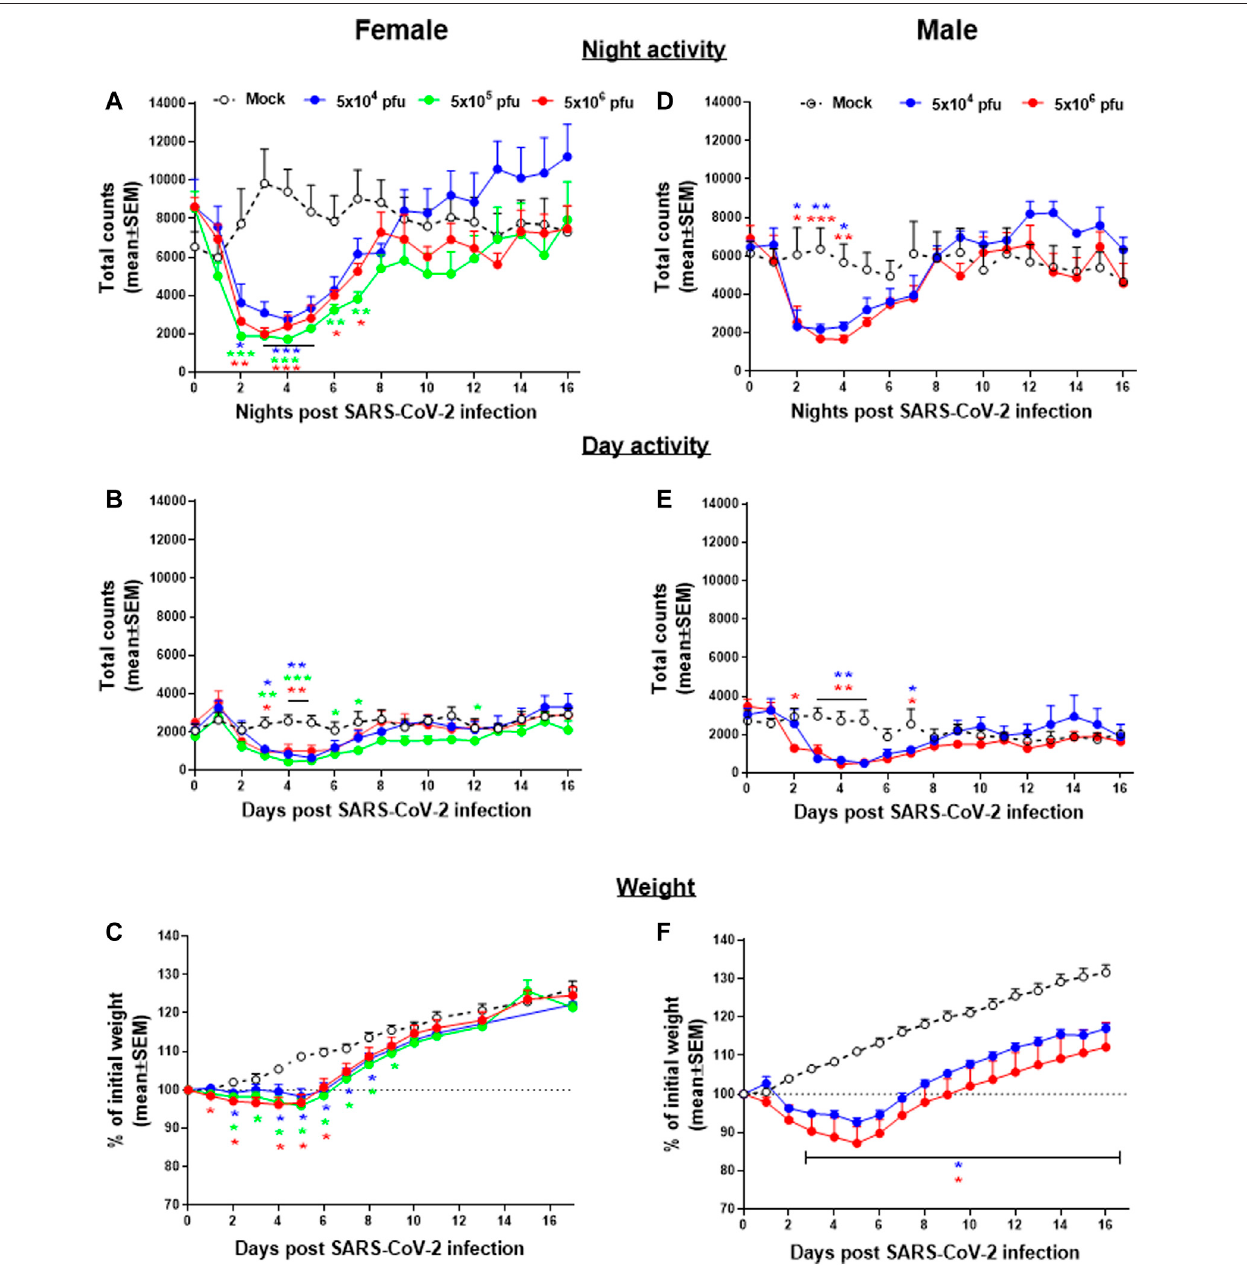
FIGURE 2 | Group activity and body weight changes in SARS-CoV-2 – infected hamsters. Total counts of activity during nighttime (5 pm – 5 am, A,D ), daytime (5 am – 5 pm, B,E ), and weight changes (C,F) over 16 days of female (A,B, and C) and males (D,E, and F) hamsters infected i.n. with different doses of SARS-CoV-2. n (cid:2) 3-5 cages with 4 hamsters/cage. * p < 0.05, ** p < 0.01, *** p < 0.001 vs Mock. Asterisks are color coded according to viral load as